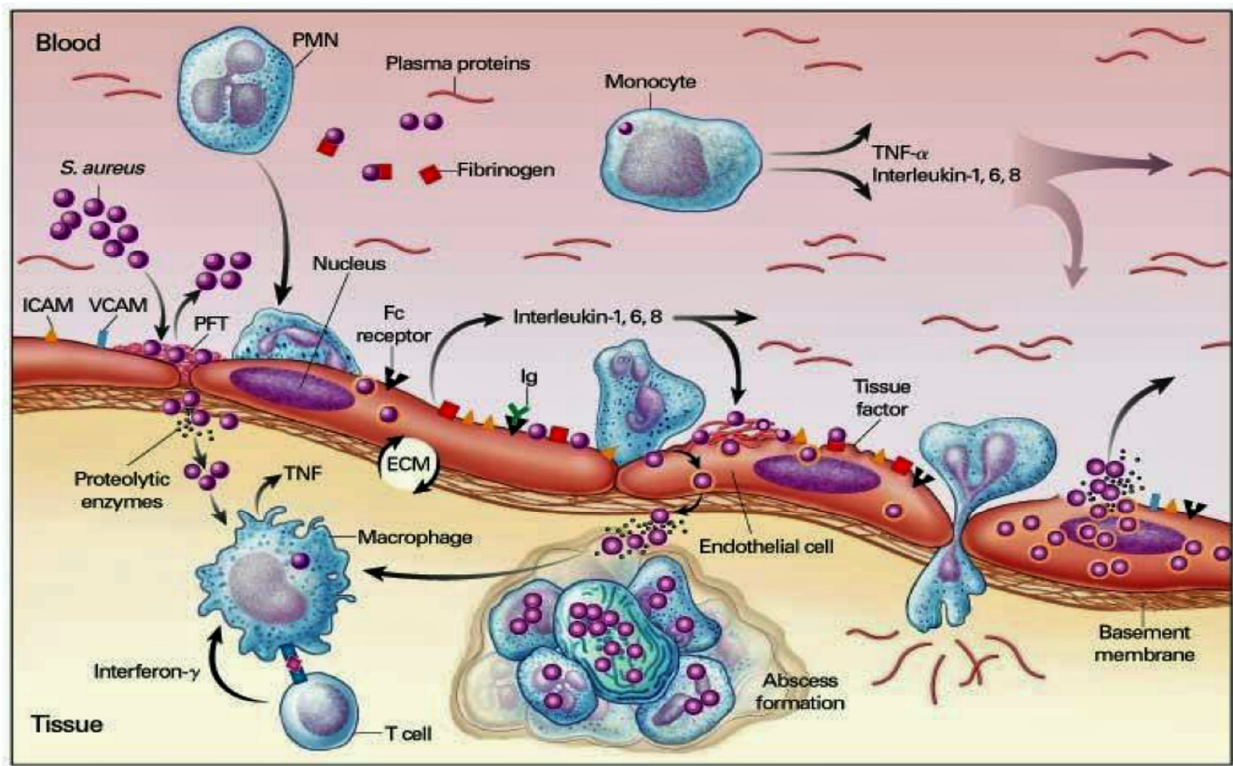
Figure 7. Bacterial adhesion induces the pathophysiological process of infective endocarditis. The